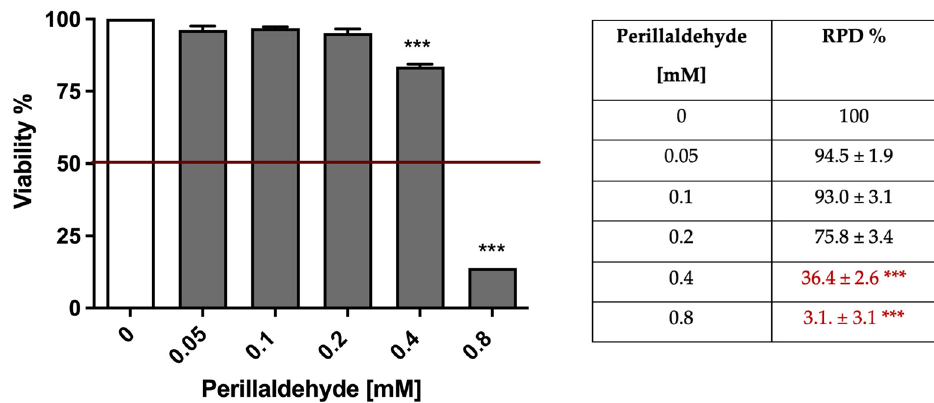
Figure 2. Cell viability ( left ) and RPD ( right ) on TK6 cells after 3 h treatment with A. leucotrichus extract followed by 23 h of recovery in the complete medium at the indicated concentrations compared to the untreated cultures (0). In red are indicated the RPD values not in compliance with the OECD recommended threshold. ** p < 0.01; *** p < 0.001 vs. 0. The cytotoxicity induced by perillaldehyde complied with the OECD guideline threshold of up to 0.4 mM. At the same time, using the RPD value, perillaldehyde complied with the OECD threshold of up to 0.2 mM (Figure 3, right panel).